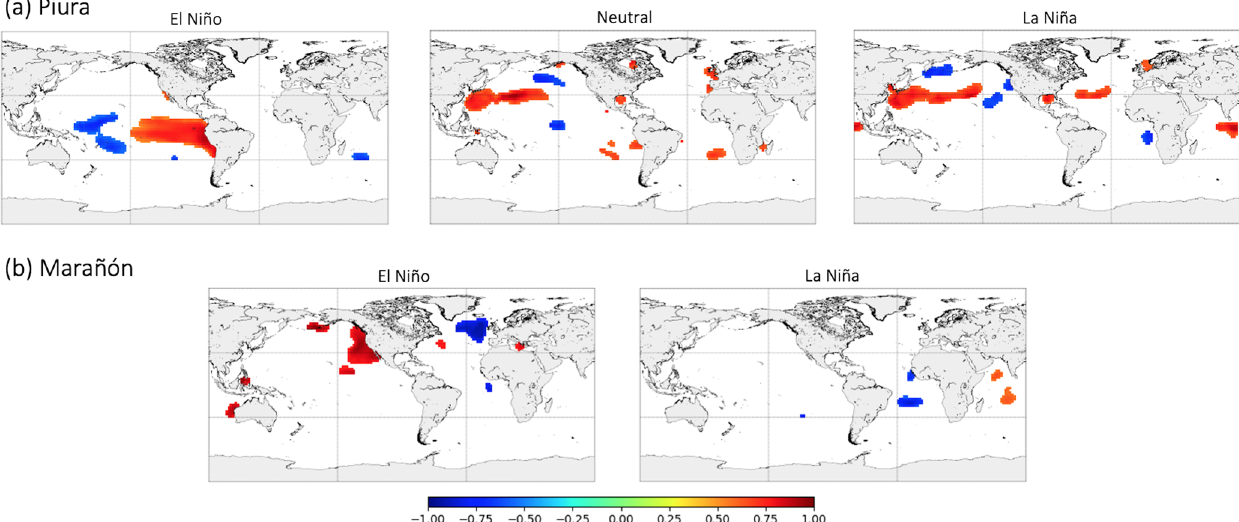
Figure 3. Correlation maps of seasonal streamflow at (a) Piura (FMA) and (b) Marañón (MAM) with preseason SSTs by ENSO phase. Only regions statistically significantly correlated at p < 0 . 05 are